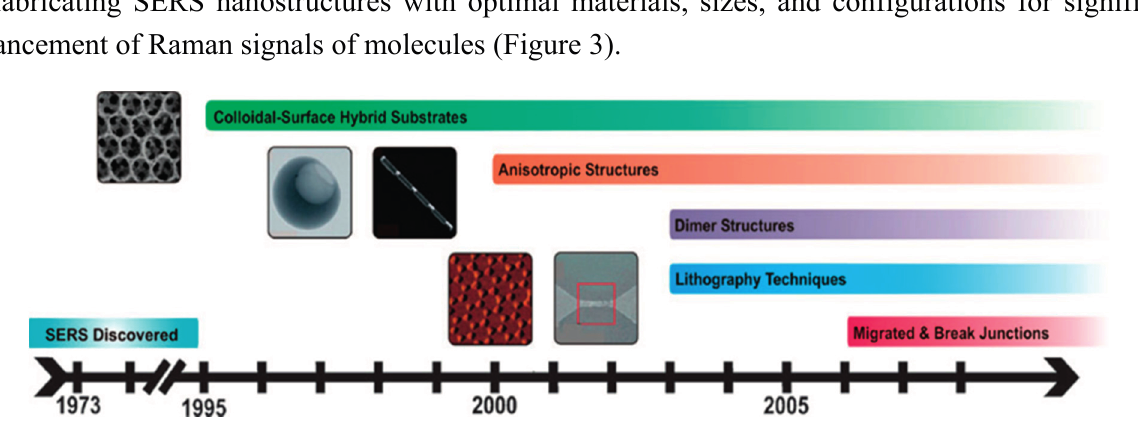
Figure 3. Progress on development of suitable SERS substrates, with permission from